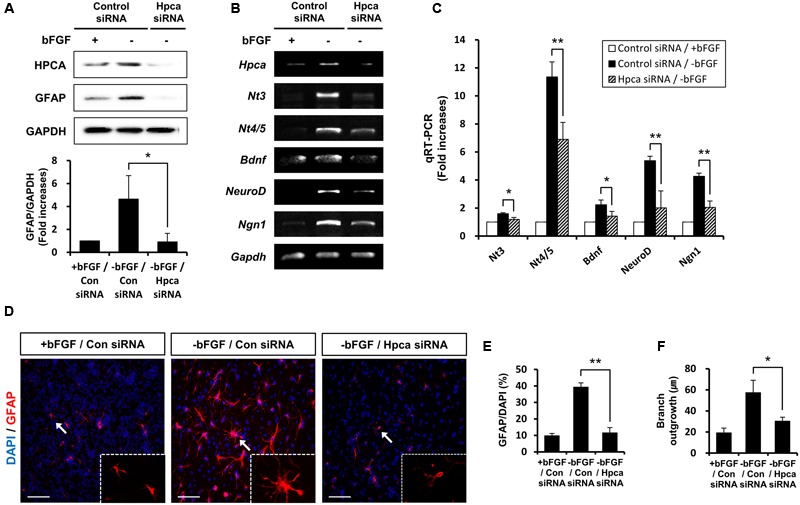
Effect of Hpca downregulation on astrocytic differentiation of HNPCs. (A–C) HNPCs were transfected with control siRNA or Hpca siRNA for 72 h and induced to differentiate by removal of bFGF for 24 h. (A) Cells were lysed and analyzed by western blotting with anti-hippocalcin, anti-GFAP, and anti-GAPDH. Graph shows mean densities as fold increases in three independent experiments (means ± SD). Band intensities were quantified with Quantity Ones® software. ∗p < 0.05 compared with the -bFGF/control siRNA. The mRNA levels of neurotrophins and proneural bHLH transcription factors were analyzed by RT-PCR (B) and real-time PCR (C). Data are means ± SD of three independent experiments. ∗p < 0.05; ∗∗p < 0.01 compared with the -bFGF/control siRNA. (D) Cells were transiently transfected with control siRNA or Hpca siRNA for 72 h and induced to differentiate by withdrawal of bFGF. After differentiation for 72 h, fixed cells were stained for immunocytochemical analysis of an astrocyte marker (GFAP, red) and anti-DAPI (blue). Bar, 100 μm. The boxed area is magnified and the arrow indicates magnified cells. (E,F) The number of GFAP-positive cells and total cells were counted and branch lengths were measured in randomly selected areas from five cultures (means ± SD). ∗p < 0.05; ∗∗p < 0.001 compared with the -bFGF/control siRNA.